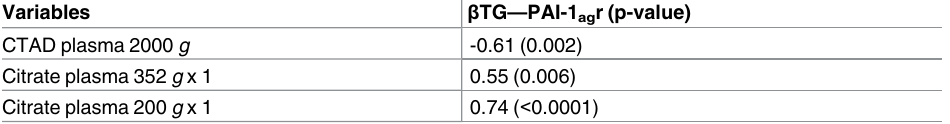
Table 6. Spearman rank order correlations between β TG and PAI-1 ag in the respective plasma prepa- rations of the follow-up